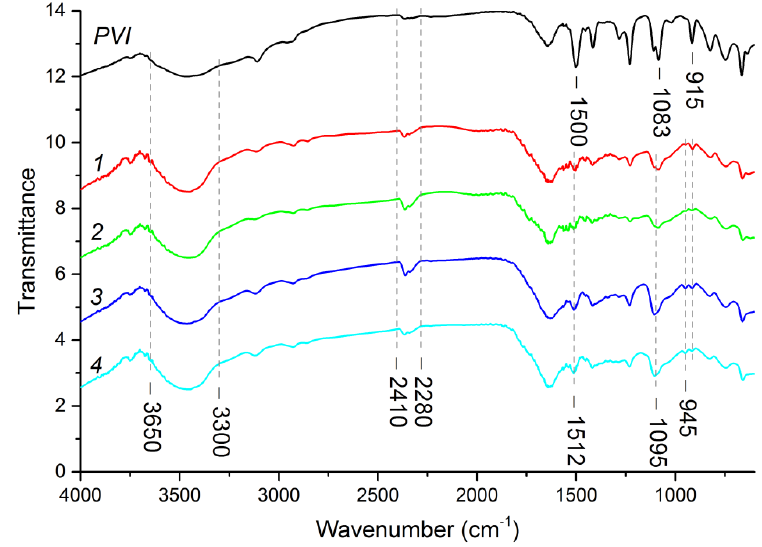
Figure 3. FTIR spectra of PVI and polymer nanocomposites with CuNPs 1 – 4 .